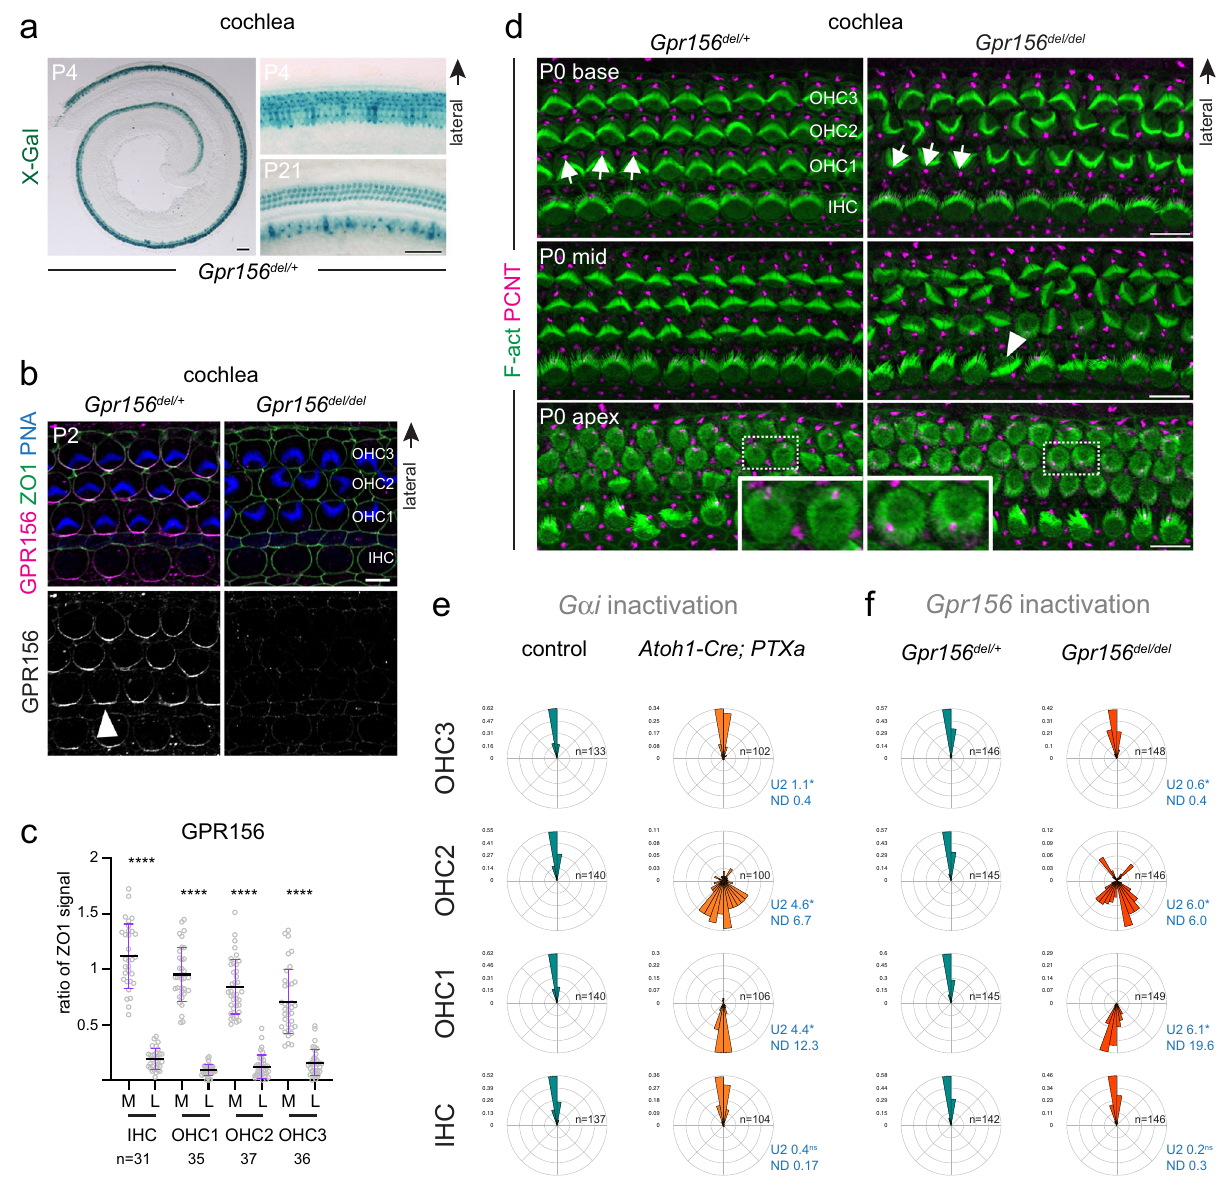
Fig. 5 GPR156 expression and hair cell orientation defects upon G α i or Gpr156 inactivation in the mouse auditory epithelium. a LacZ reporter is speci fi cally expressed in HCs in the Gpr156 del/ + auditory epithelium at P4 and P21 (right panels: cochlear base). b GPR156 immunolabeling shows polarized protein enrichment at the medial HC junction in control (left, arrowhead) but not Gpr156 mutant cochlear HCs (right). Peanut agglutinin (PNA) labels hair bundles in OHCs. c GPR156 enrichment per cochlear HC type at P0 (base) at the medial (M) and lateral (L) junction. GPR156 is expressed as ratio of ZO1 signal (mean ± SD; n, HC numbers in 3 animals; Mann-Whitney test (two-tailed), **** p < 0.0001). d P0 auditory epithelium at 3 positions along the cochlea (base, 15%; mid, 50%; apex, 75%). PCNT and phalloidin labeling respectively reveal HC orientation by the position of the off-center basal body and the hair bundle shape. Arrows indicate OHC1 orientation and the arrowhead indicates a rare misoriented IHC. Magni fi ed insets: less mature OHCs at the apex are already reversed in orientation (see also Supplementary Fig. 5c-d). e , f Circular histograms of P4 HC orientation by row. Histograms show frequency distribution at 50% cochlea position (10° bins in a referential where 90° (top) is lateral and 0° (right) is towards the cochlear base; n indicates HC number in 5 – 7 animals; Watson U2 test of homogeneity; normalized difference (ND) value indicates how many standard deviations separate the circular means of each distribution). In e, PTXa indicates the Cre-inducible R26-LSL-PTXa allele. Littermate controls for Atoh1-Cre ; PTXa are Cre-negative PTXa animals. Scale bars are 100 µ m ( a , left), 50 µ m ( a , right), 5 µ m ( b ), 10 µ m ( d